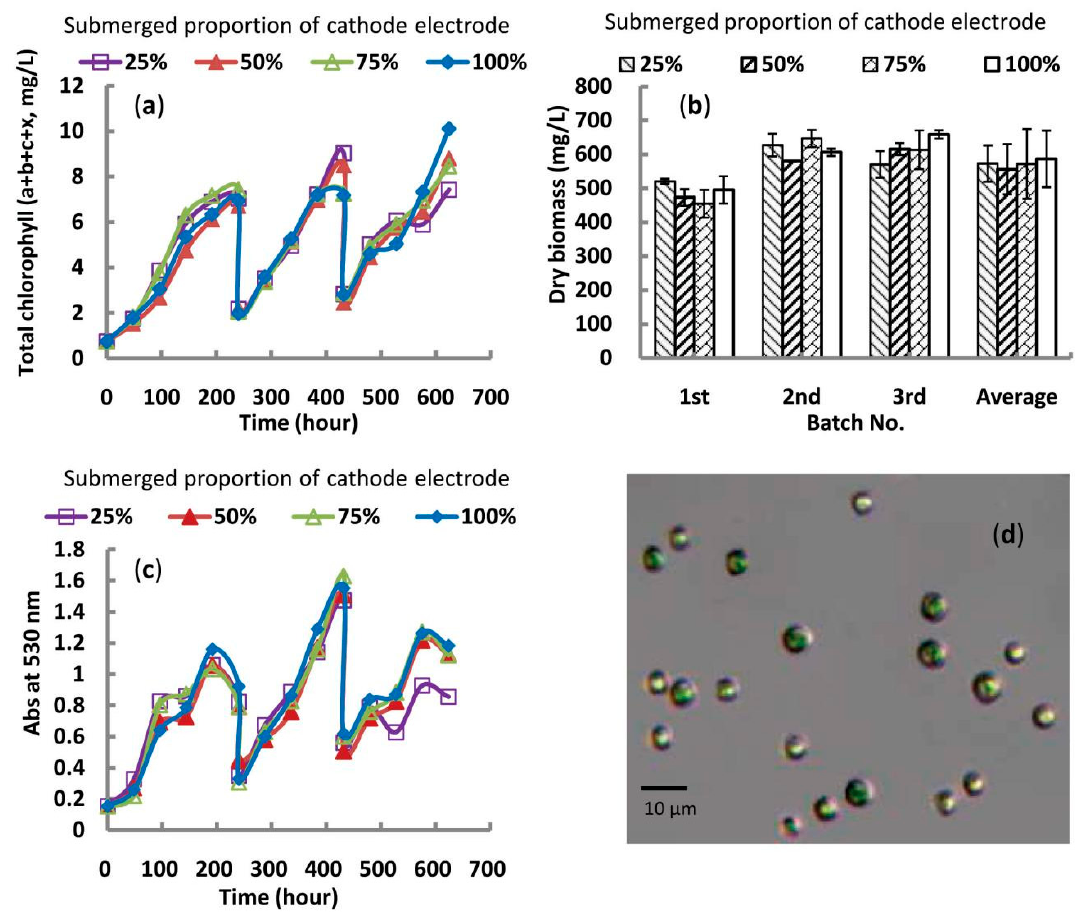
Figure 3. Biomass and lipid production of microalgae from wastewater with partially and completely submerged electrodes in the cathode chamber. ( a ) Total chlorophyll (a + b + c + x); ( b ) Biomass production of microalgae at the end of batch culture; ( c ) Lipid production estimated by sulfo-phospho-vanillin assay at 530 nm; ( d ) Optical microscopic observation of microalgae cultured in the unpasteurized swine wastewater digestate (magnification × 400). The data shown are the average values of the two identical MFCs within each test group.